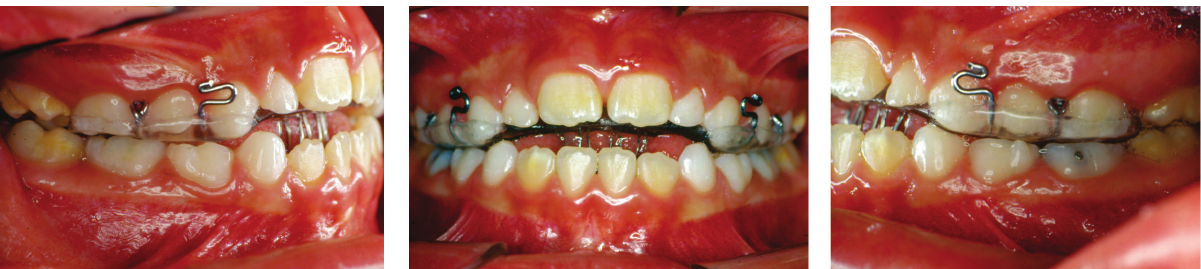
Figure 4- Removable appliance with grid